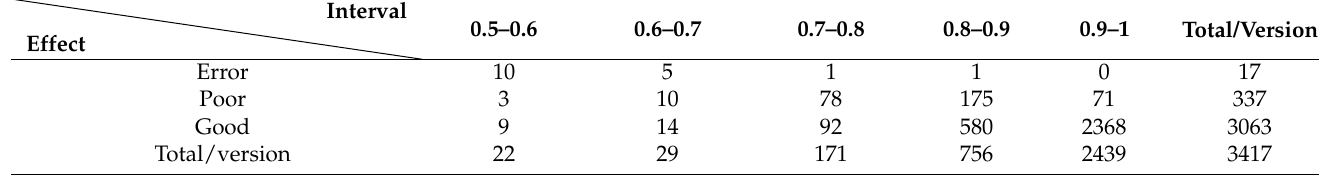
Table 3. Sample table of the relationship between contributor reputation and data